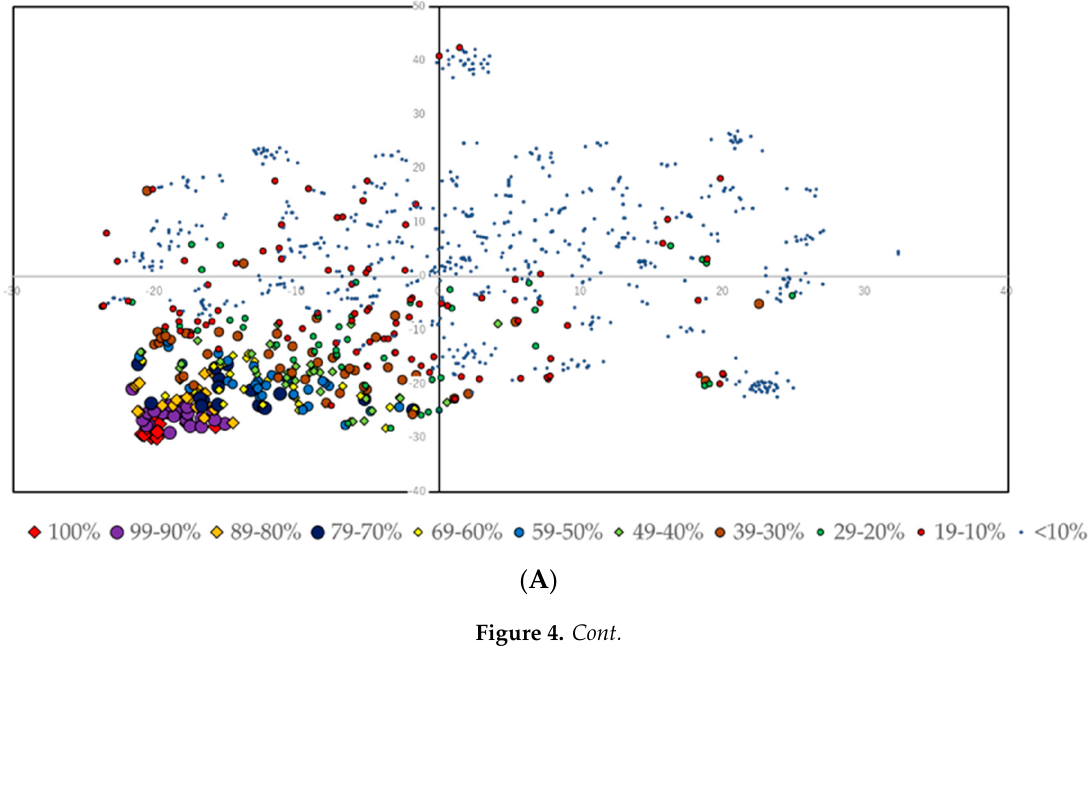
( B ) Figure 4. Ordination analysis as a function of t-distributed stochastic neighbor embedding (t-SNE) plot categorized by ( A ) prevalence and ( B ) genus. 4. Discussion In this study, we investigated 85 healthy people at the age of 90, focusing on analyzing their core oral microbiome. On the basis of the pyrosequencing analysis, 389,927 valid reads were obtained, and 1216 species were detected. Thirteen species were detected in all 85 subjects. Among them, seven belonged to the Streptococcus genus. These species represent potential candidates for the core human oral microbiome. In this study, the most abundant phylum was Firmicutes, whereas Streptococcus constituted 45% of the genera present. The microbiome structure on the phylum level was categorized as follows: Firmicutes (62.7%), Bacteroides (9.6%), Proteobacteria (3.8%), Fusobacteria (2.7%), and Actinobacteria (20.3%). A previous study investigating subjects aged 60 years and older in China showed that the abundant phyla were Firmicutes (29.6%), Bacteroides (22.4%), Proteobacteria (20.4%), Fusobacteria